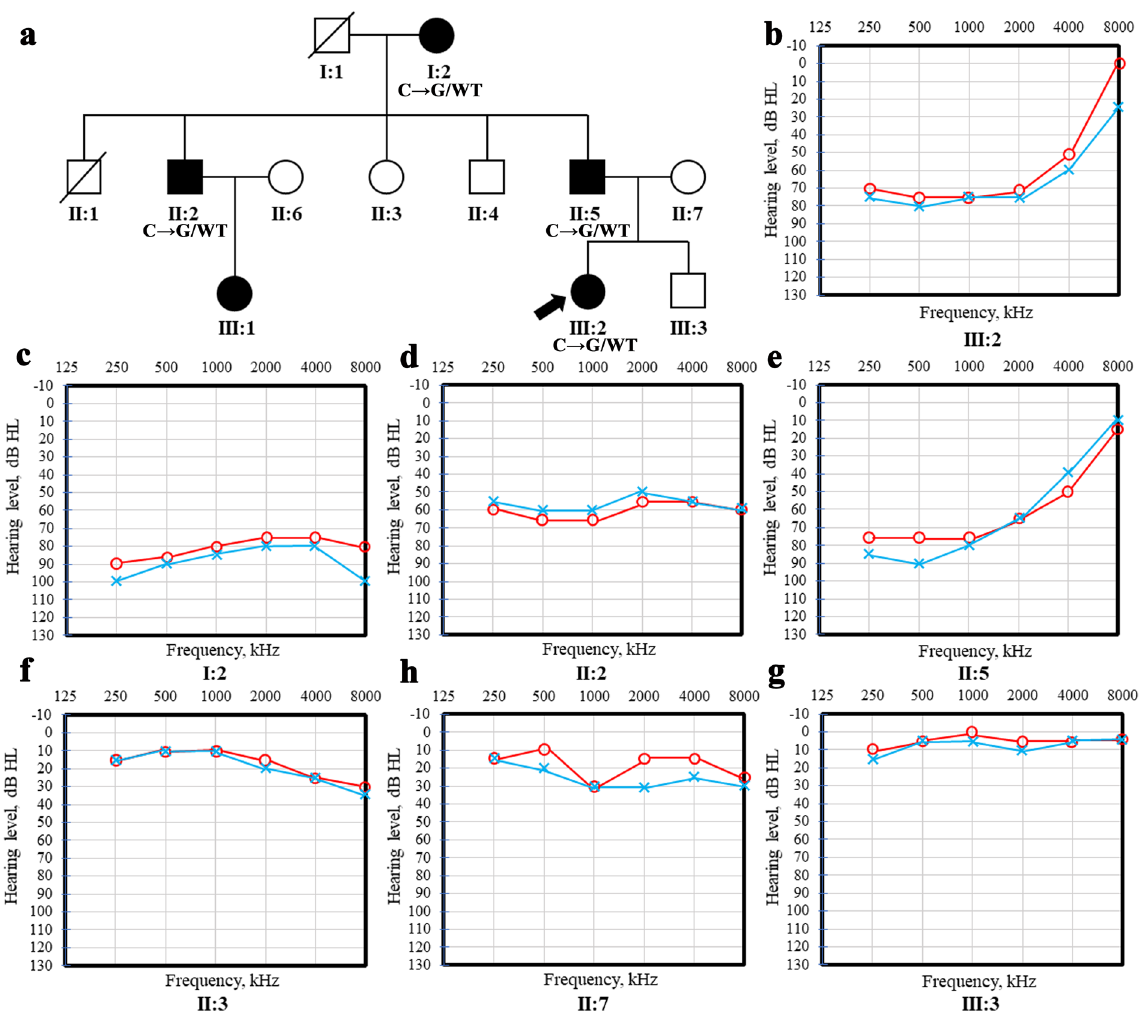
Figure 1. Combined figure. ( a ) Pedigreed diagrams of the family with autosomal dominant hearing loss (symbols with line, deceased). The affected subjects are denoted in black. The proband is indicated by an arrow. ( b – g ) Audiograms of the family subjects (red: right ear; blue: left ear). ( b – e ) Audiogram showed bilateral sensorineural hearing impairment of affected subjects. ( f–h ) tonal audiometric curves of unaffected family members.